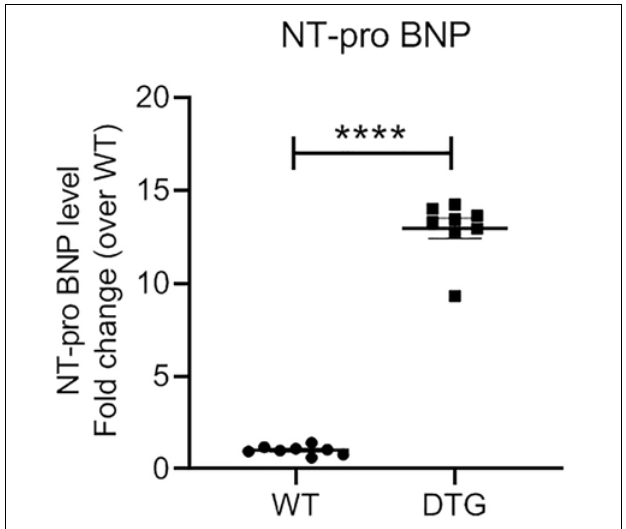
FIGURE 2 | Plasma NT-proBNP level in DTG and WT mice. Data are presented as mean ± SEM with **** p < 0.0001 vs. WT, unpaired Student’s t -test. N =